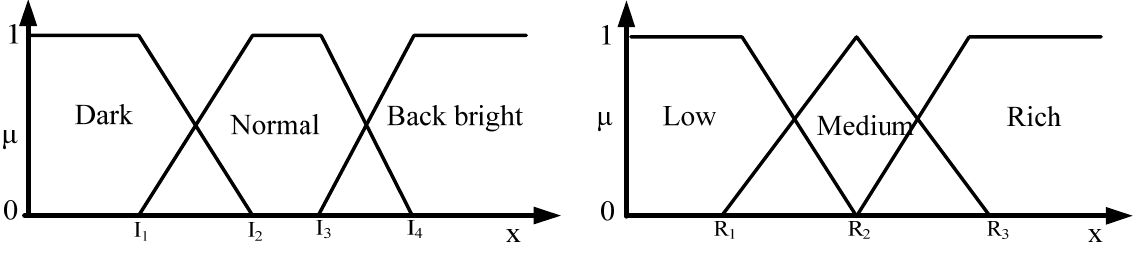
Figure 2. The membership functions of illumination and the membership functions of red.